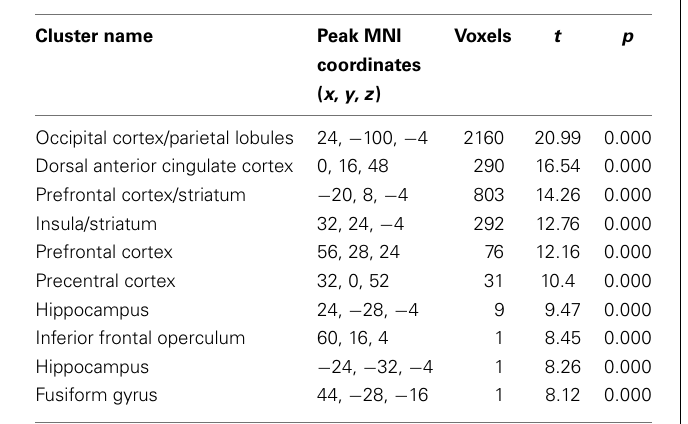
Table 2 | Localization of activations for task related activation clusters [voxels showing significant activity ( t = 7.94, p = 0.00001, family wise error (FWE) correction for multiple comparisons), irrespective of group, and across both conditions].